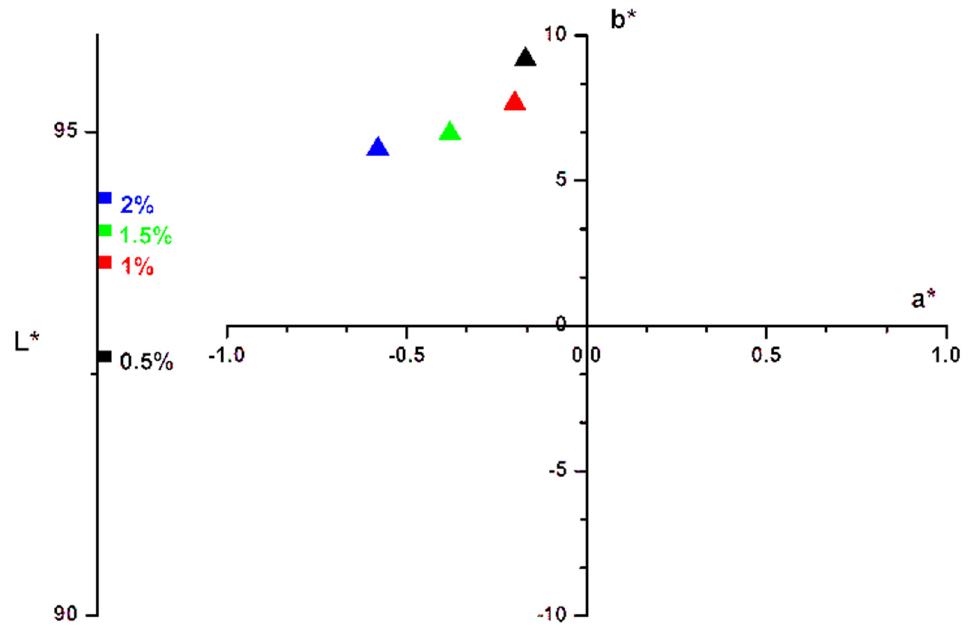
Figure 8. CIEL*a*b* properties of the bioester B3 of the ester acrylic film at different ester concentration. Table 4. Color differences of the ester acrylic film at different ester The total color difference Δ E* ab may be calculated with the Equation (1) [17,62,63 ] , results being presented in Table 4.